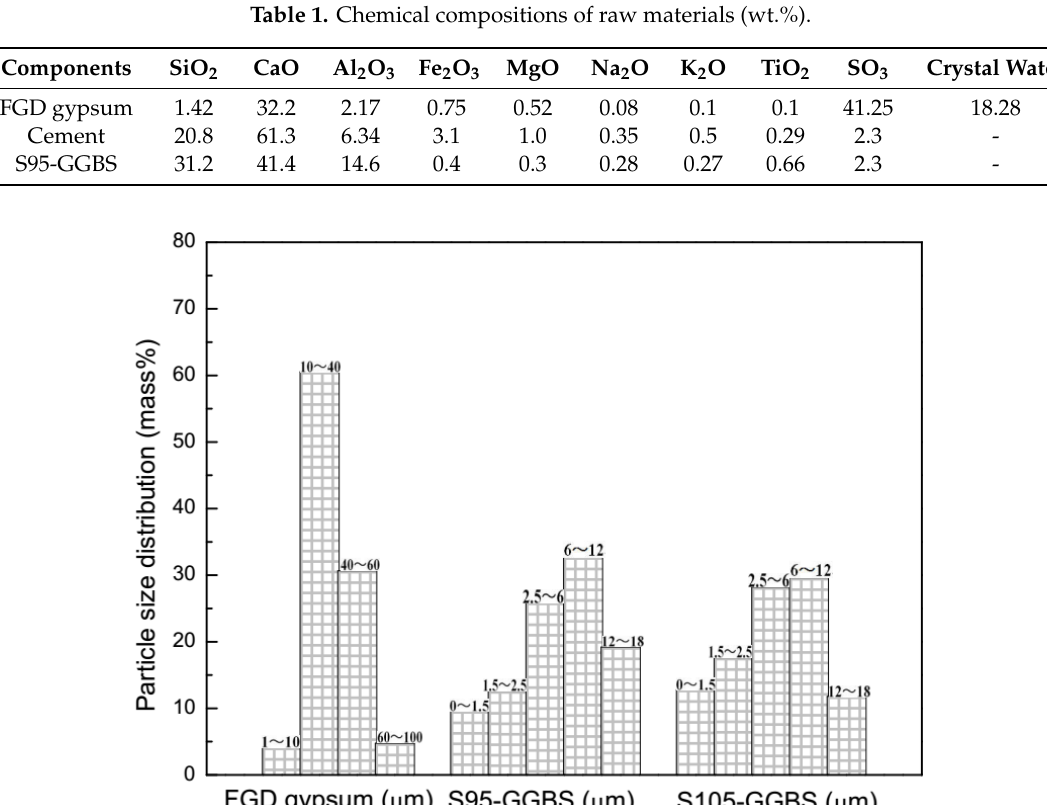
Figure 1. The particle size distributions of FGD gypsum and GGBS.